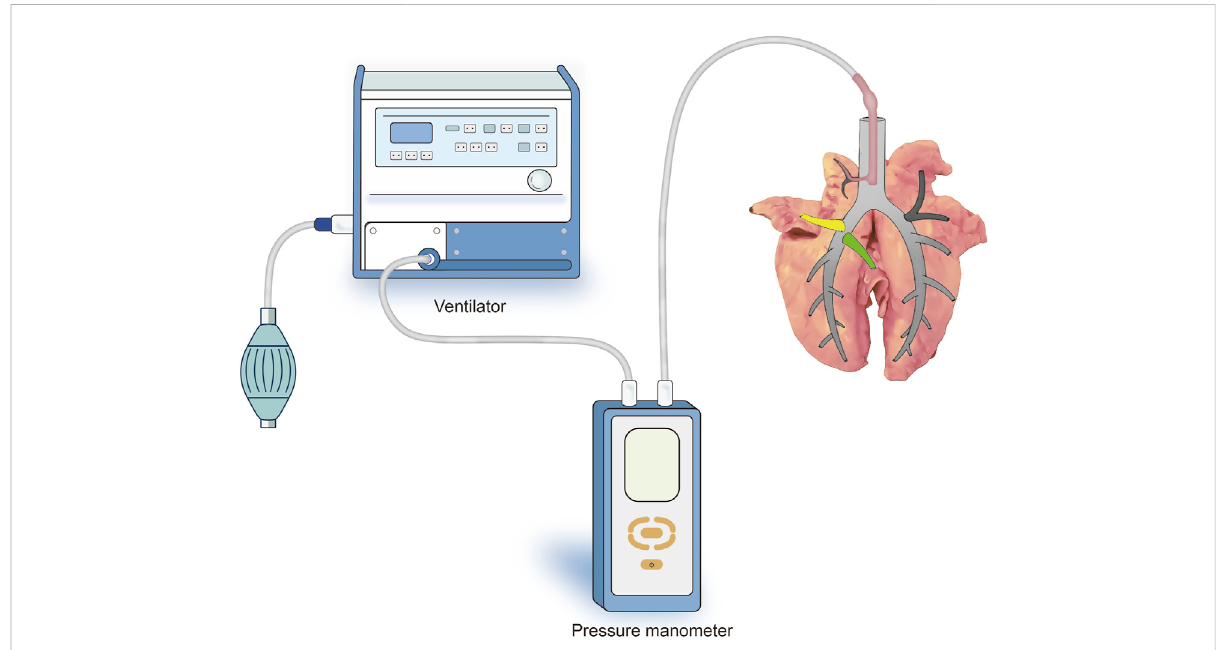
FIGURE 2 Schematic representation of the experimental setup for ventilating the target segment and measuring the pressure in the airway. The 12-Fr cuffed endotracheal tube attached to the mechanical ventilator was inserted into the six segmental bronchi sequentially to ventilate the target segment and the cuff was in fl ated to ensure air tightness (At this point, the endotracheal tube was inserted into the R1a